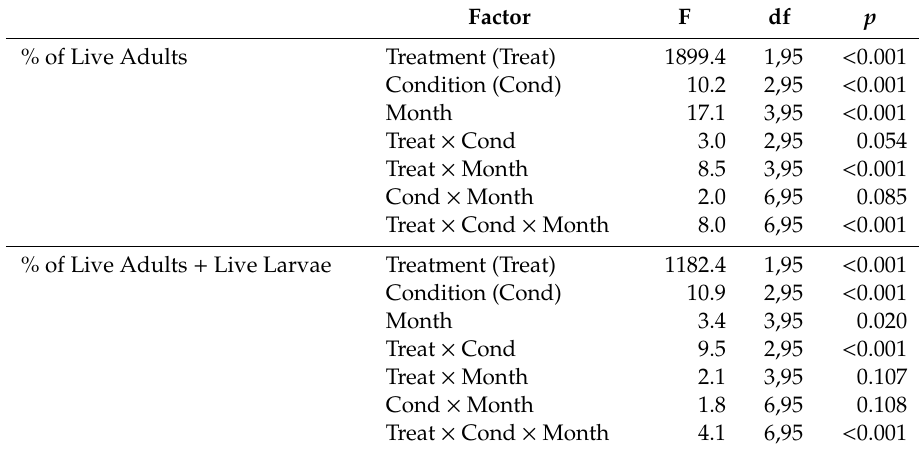
Table 8. Overall ANOVA (Proc Mixed, Statistical Analysis System, Version 9.4) for percentage of live T. granarium adults 30 days after larvae were placed on the arenas and the percentage of live adults + live larvae after 30 days. Main e ff ects were treatment (untreated controls versus the pyrethrin + methoprene + piperonyl butoxide formulation (IGR), condition (larvae exposed on the clean treated arenas, the food-treated arenas, and the untreated arenas with transferred treated food), and month post-treatment (0, 1, 2, or 3).